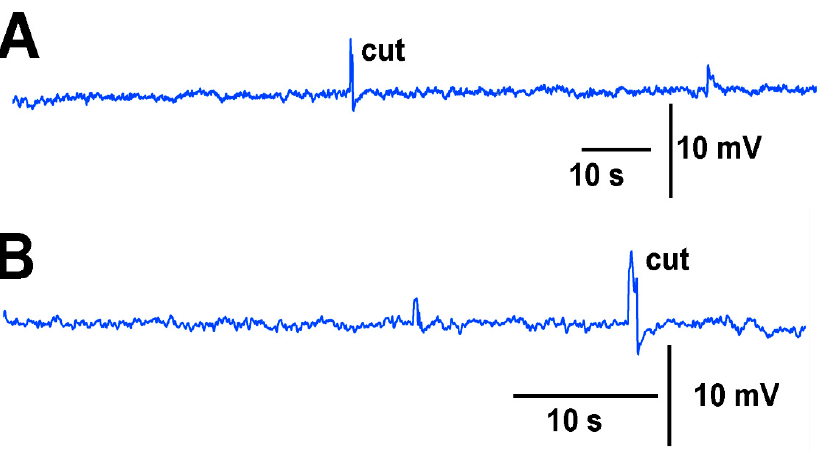
Figure 11. Long term recordings performed with impedance measures in a tomato plant. The leads of the wires were placed within the stem of a tomato plant. ( A ) After 5 min of recording a leaf tip was cut. ( B ) After 6 h of continuous recording another leaf tip was cut of the same degree, at about the same height on the plant.